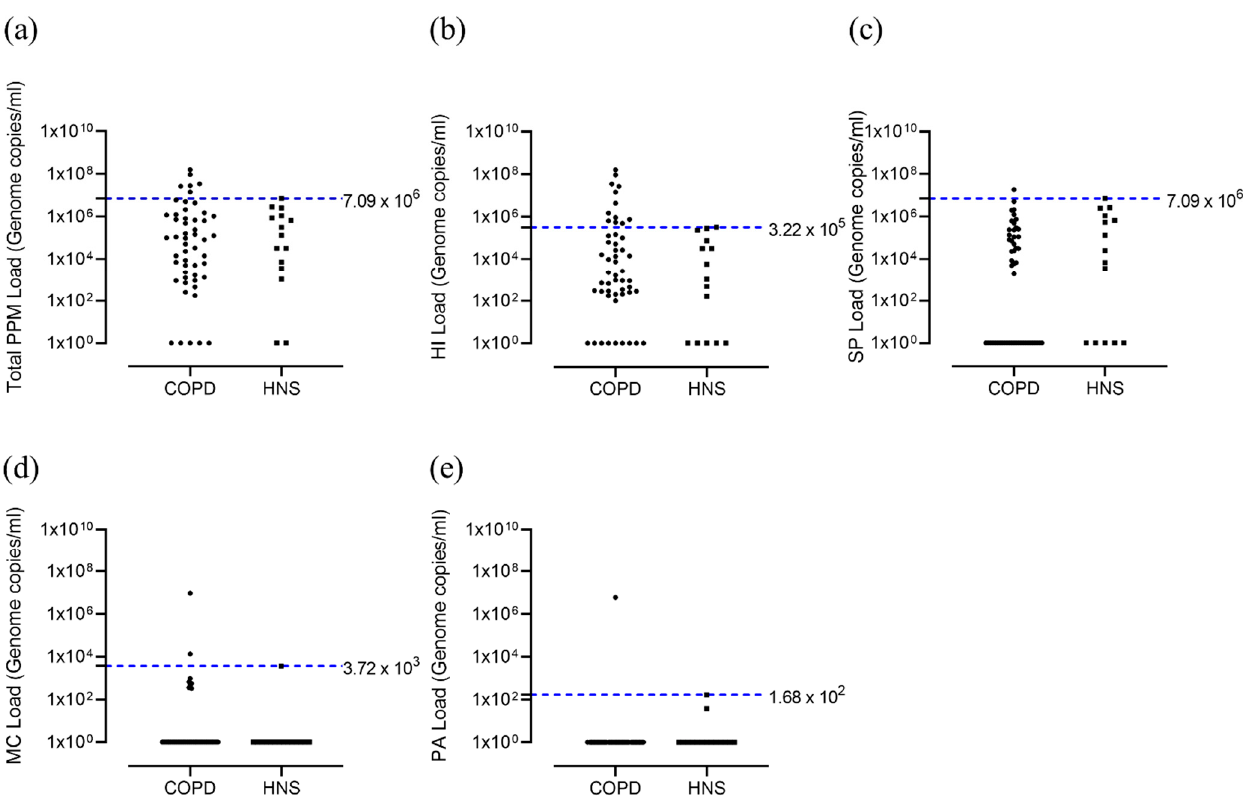
Figure 1. Total bacterial load and load for different PPMs; COPD vs. HNS controls at baseline. Sputum from COPD patients ( n = 52) at baseline visit and healthy non-smokers ( n = 15) were analysed for qPCR for presence of H. influenzae , S. pneumoniae , M. catarrhalis and P. aeruginosa. Data represent bacterial genome copies for individual patients for ( a ) total bacterial load and that for different bacterial species; ( b ) H. influenzae , ( c ) S. pneumoniae , ( d ) M. catarrhalis and ( e ) P. aeruginosa . Chronic obstructive pulmonary disease, COPD; healthy non-smoker, HNS; Haemophilus influenzae , HI; Moraxella catarrhalis , MC; Pseudomonas aeruginosa , PA; potentially pathogenic microorganism, PPM; Streptococcus pneumoniae ,